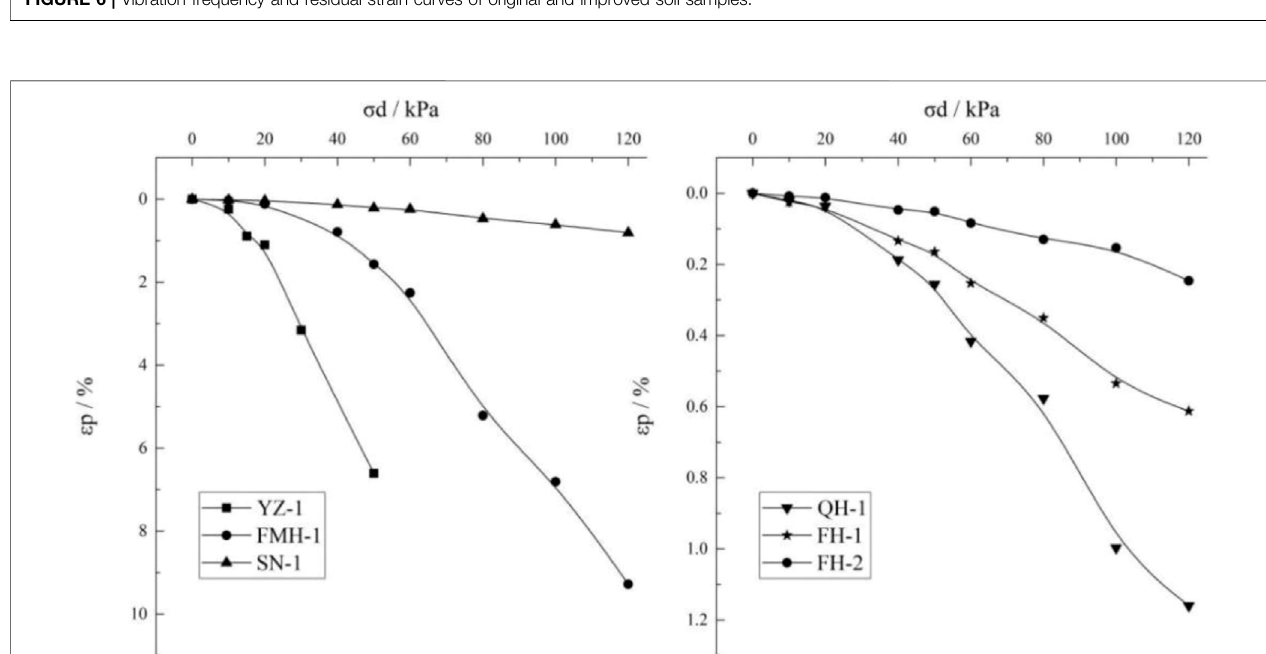
FIGURE 6 | Vibration frequency and residual strain curves of original and improved soil samples.